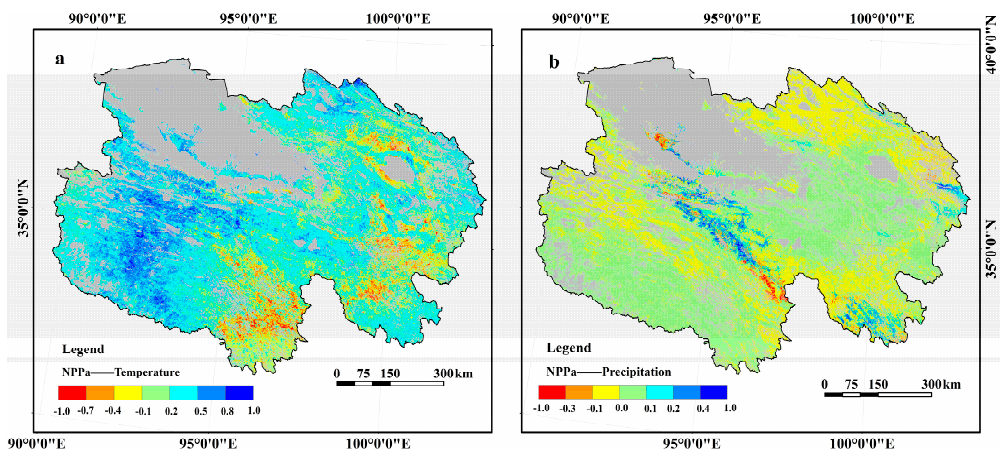
Figure 7. Spatial patterns of the correlation coefficients between NPP a and temperature, NPP a and precipitation from 2001 to 2016. 271